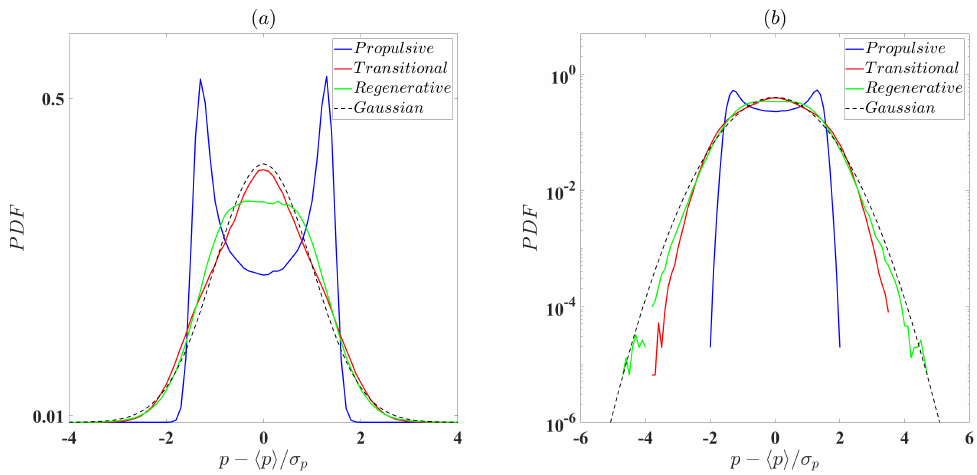
Figure 11. Probability density function of the tonal component of pressure signals for each operational condition. The PDFs are reported in both linear ( a ) and logarithmic scales ( b ).